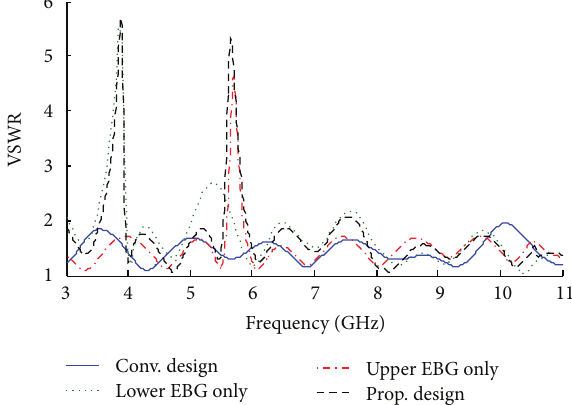
Figure 4: VSWR simulations for four different 𝑑 𝑠 values.